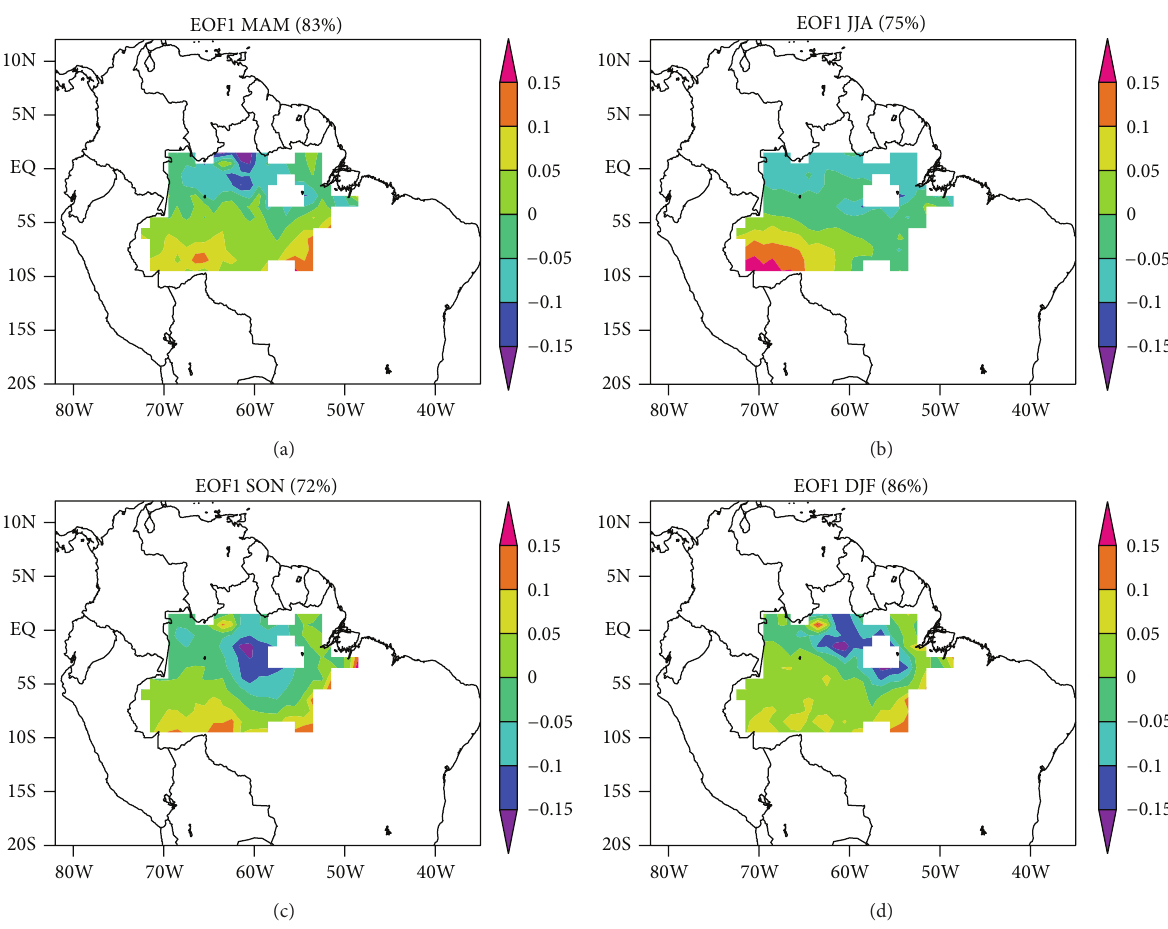
Figure 6: First EOF of the remotely sensed LST anomalies at 6:30 a.m. over Amazon rainforests for the following seasons: (a) MAM, (b) JJA, (c) SON, and (d) DJF.